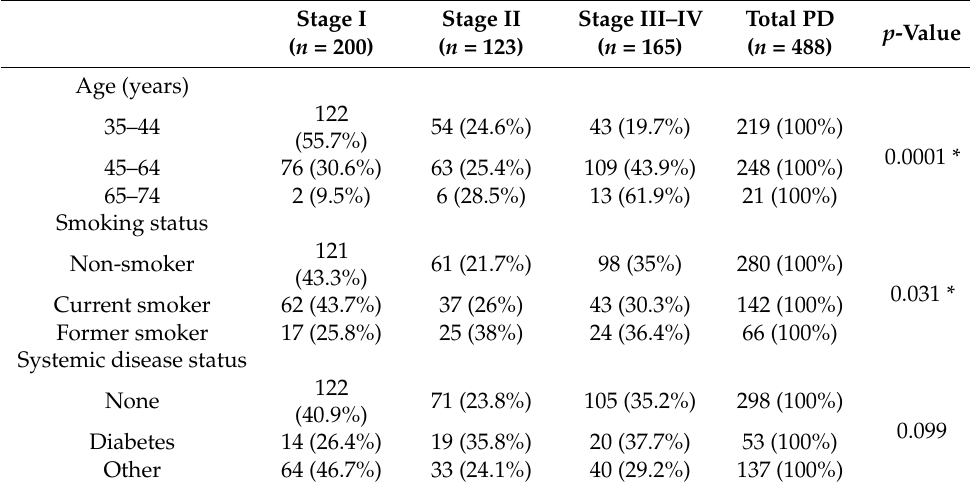
Table 2. Severity of periodontitis by the characteristics of the EFP/AAP (European Federation of Periodontology/American Academy of Periodontology) 2018 classification.